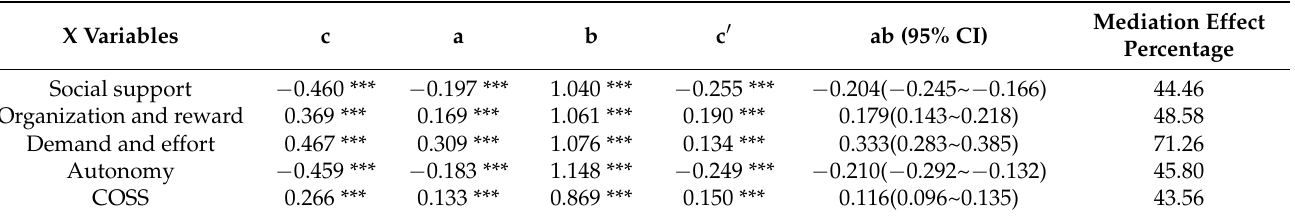
Table 7. Analysis of the mediating effect of cumulative fatigue between occupational stress and depressive symptoms.